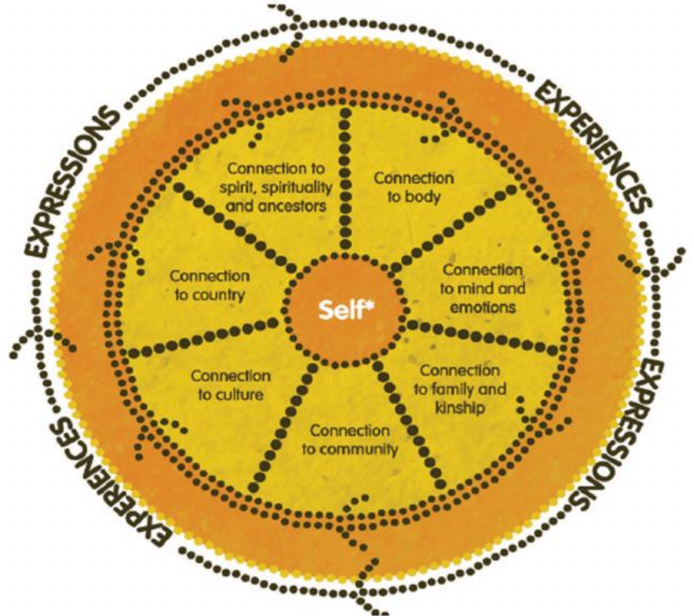
Figure 1. Social and Emotional Wellbeing from an Aboriginal and Torres Strait Islanders’